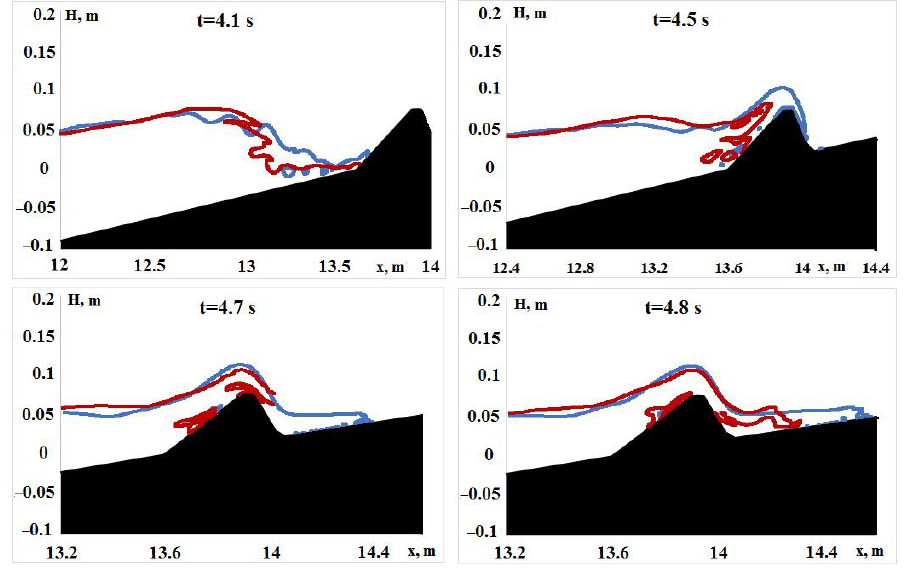
Figure 11. Comparison of the wave profiles for setup 4 ( —without TM, —with TM).